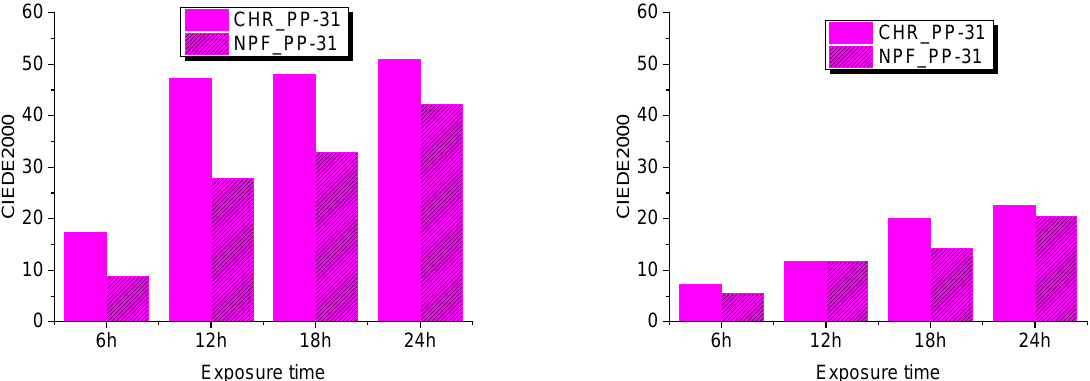
Figure 8. CIEDE2000 difference measured at 20 °C ( left ) and at 45 °C ( right ) on both test substrates printed with PP-31. Color difference results on both PP-31 and OY-12 prints are significantly smaller when thermochromic colorant is inactive that is, when measured above its activation